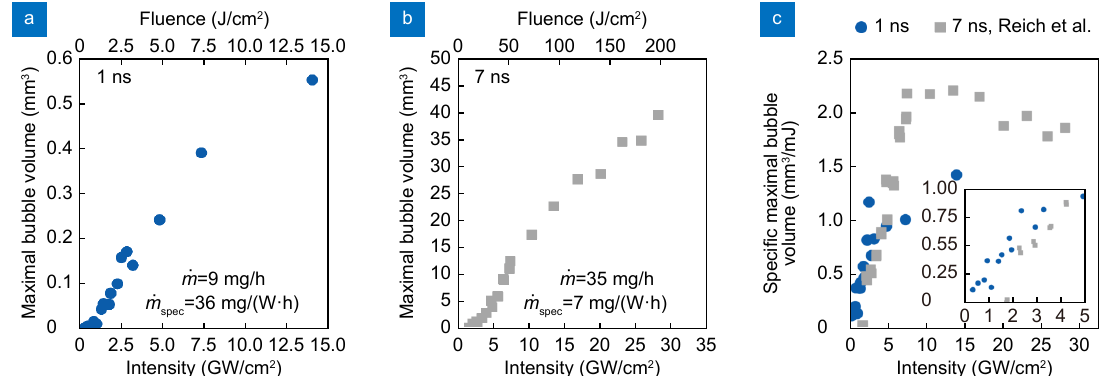
Fig. 2 | The maximal cavitation bubble volume for different laser intensities are shown for a 1 ns laser (a) and a 7 ns laser (b) 67 . The pro- ductivity m and the ablation efficiency m _spec in (b) are taken from ref. 20 . For both lasers, the productivity and ablation efficiency are determined at 12 J/cm 2 . Moreover, the powerspecific maximal CB volume is shown for both lasers ( c